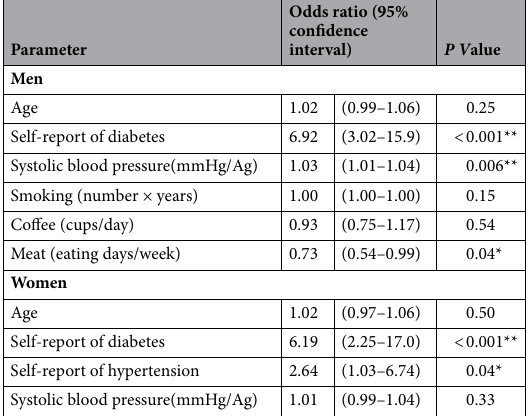
Table 4. Multivariate risk factors associated with retinal vascular events. * < 0.05, ** <